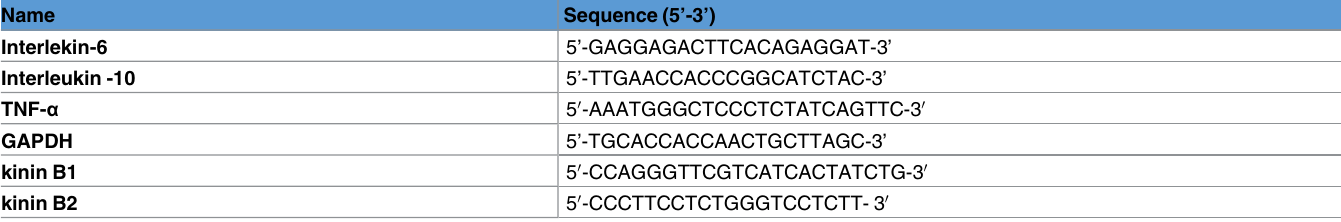
Table 1. PCR primer